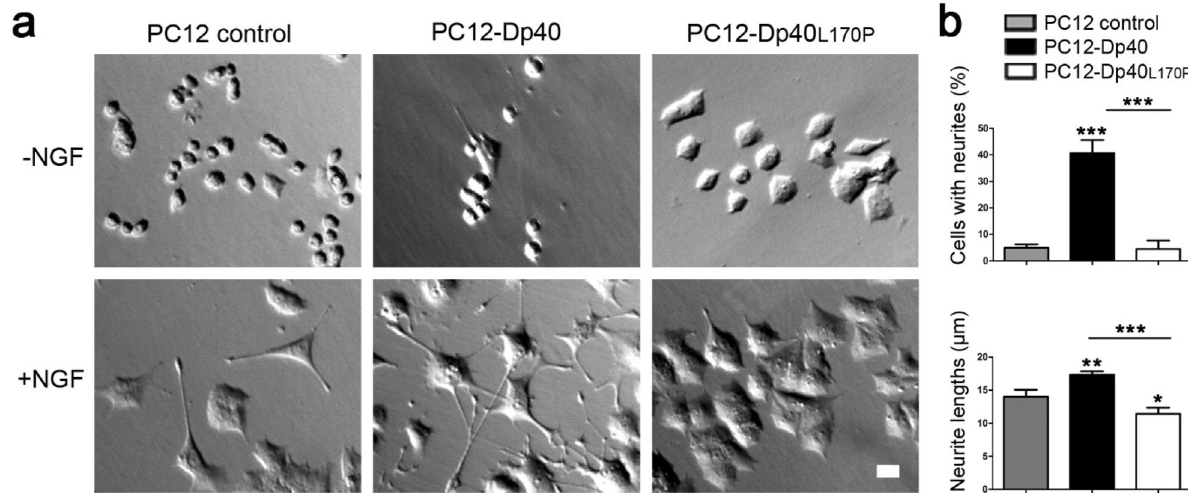
Figure 1. Morphometric analysis of undifferentiated and NGF-differentiated PC12-Dp40 and PC12- Dp40 L170P cells. PC12 control, PC12-Dp40 and PC12-Dp40 L170P cells were differentiated with NGF for 9 days. ( a ) Morphometric analysis was performed using clear-field micrographs of the undifferentiated (top panels) and differentiated PC12 cells (bottom panels). ( b ) Quantification of the differentiation ratio of the NGF- differentiated PC12 control, PC12-Dp40 and PC12-Dp40 L170P cells. Top panel : percentage of cells with neurites. Bottom panel : average of neurite lengths. * P ˂ 0.05, ** P ˂ 0.01, *** P ˂ 0.0005 compared to the PC12 control or PC12-Dp40 versus PC12-Dp40 L170P cells. The scale bar represents 10